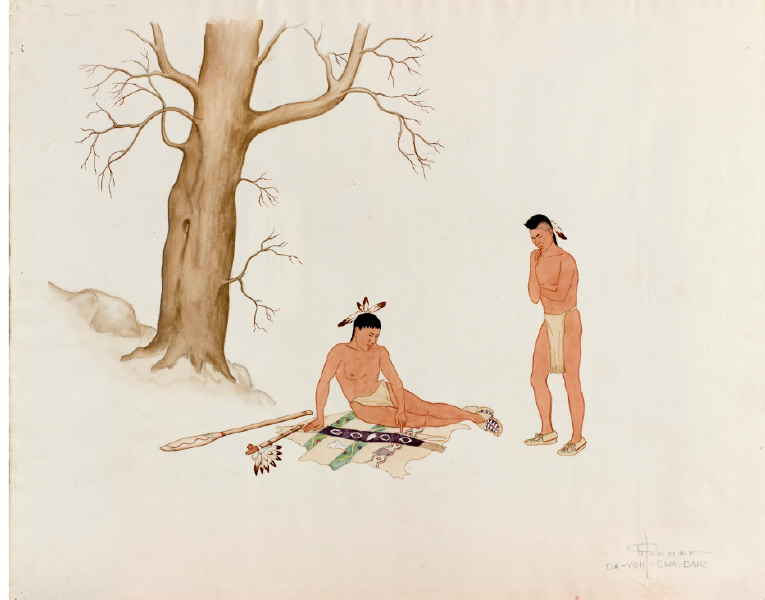
Figure 7. Sanford Plummer, “Meeting of Hiawatha and [the Peacemaker]”, 1936. Watercolor on paper, with permission of the Newark Museum of Art.